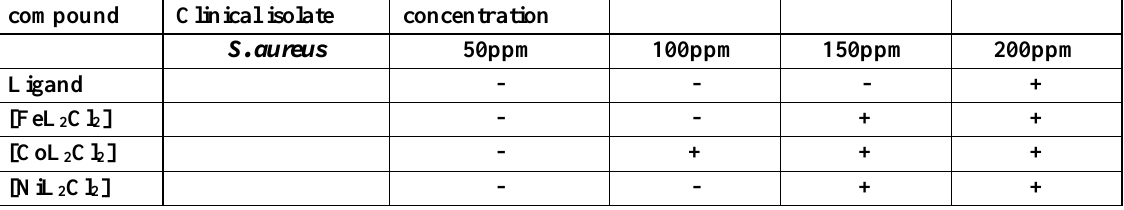
Table 6. Minimum inhibitory concentration (MIC) of Schiff base ligand and its metal complexes .